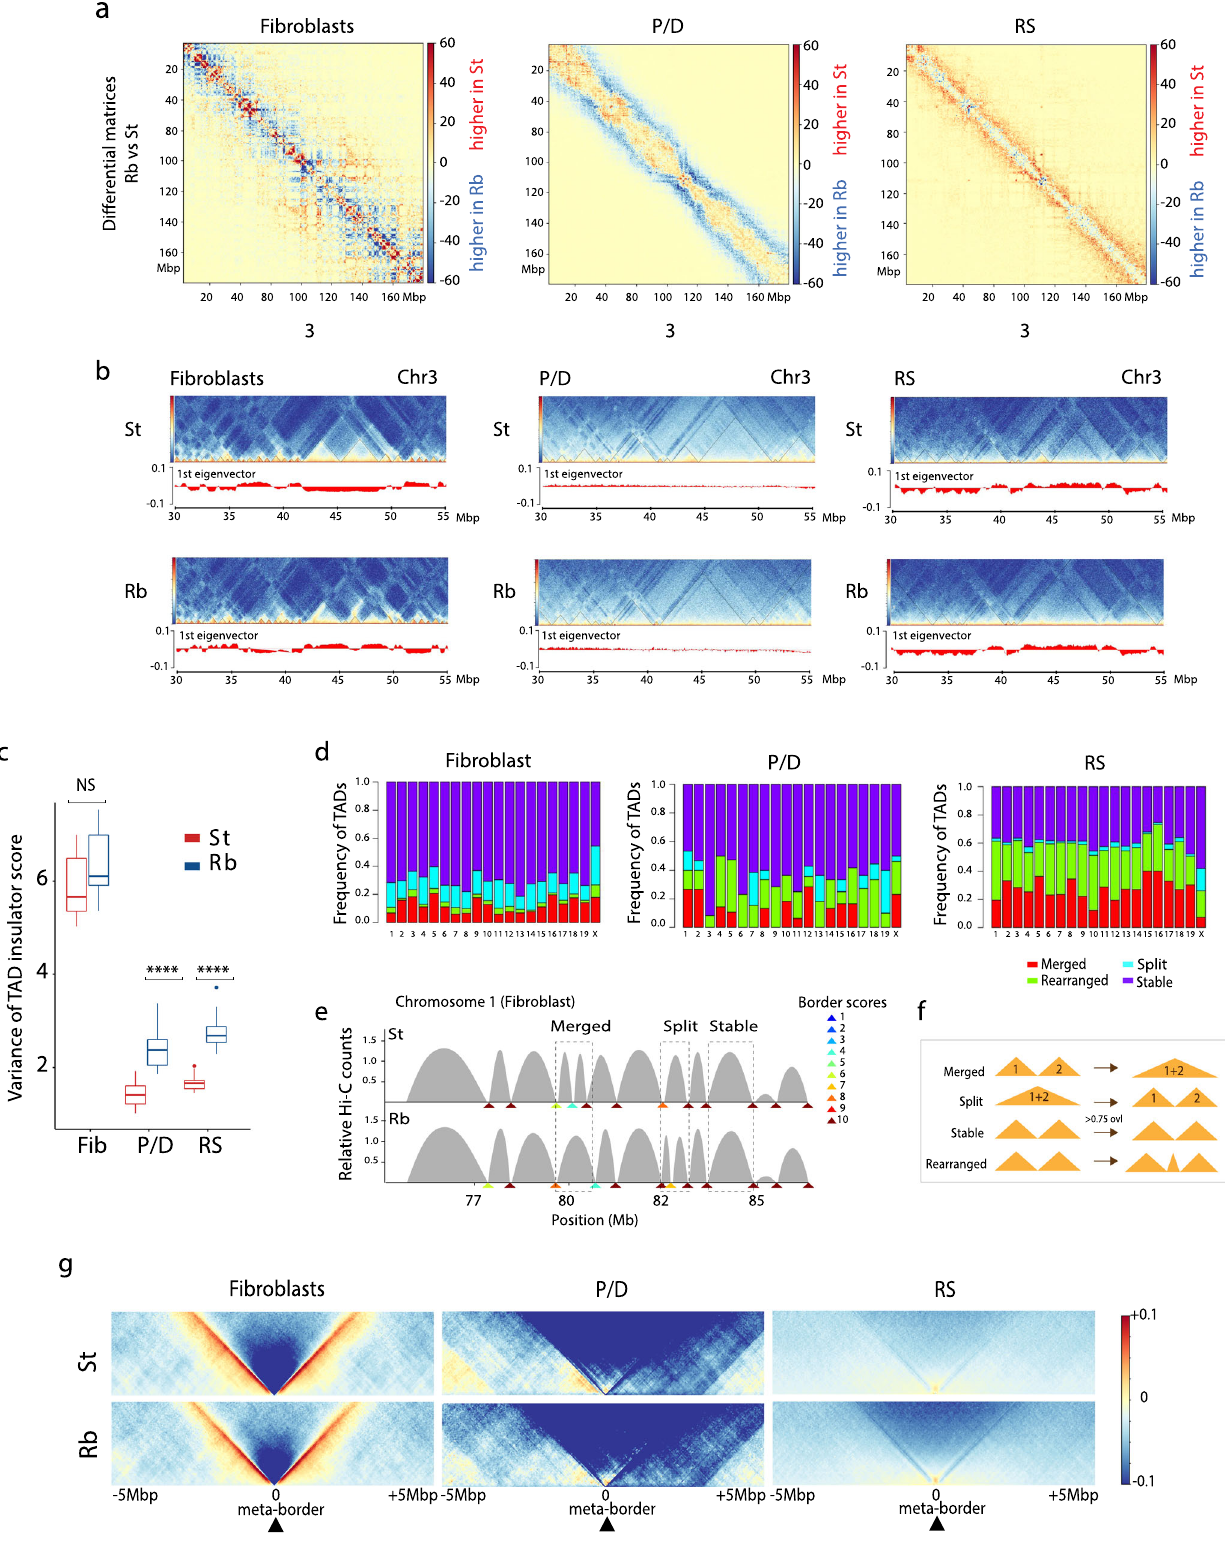
TADs detected, when compared to somatic cells ( n = 288 in Rb and n = 294 in standard). The TAD insulation score variance was higher in Rb mice (Fig. 5c). Moreover, meta-border plots show asymmetric TAD borders (Fig. 5g), more characteristic of stripe TAD domains 33 . The variance of TAD insulation scores was